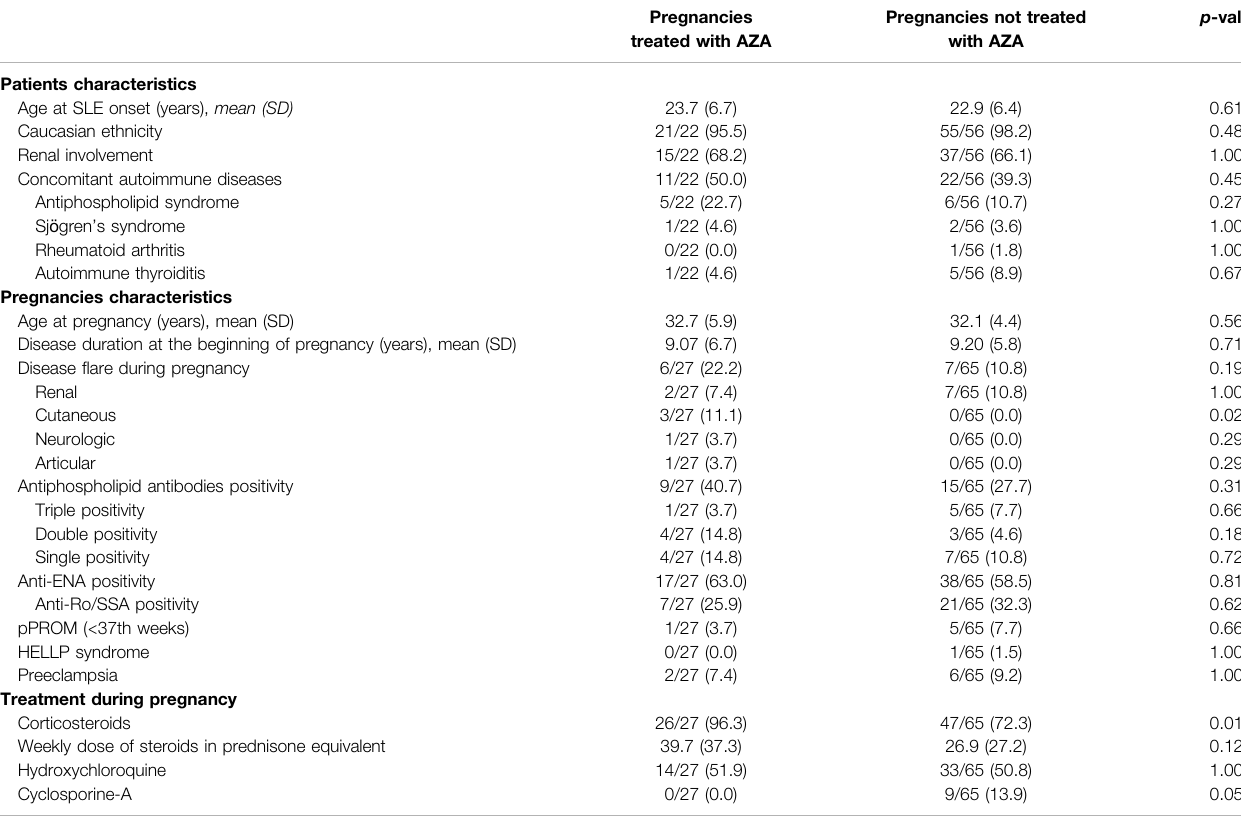
TABLE 1 | Univariate analysis ofthe case-control study comparingSLE pregnancies treated withAZA (cases; n patients (cid:1) 22, n pregnancies (cid:1) 27) and not treated with AZA (controls, n patients (cid:1) 56, n pregnancies (cid:1) 65).